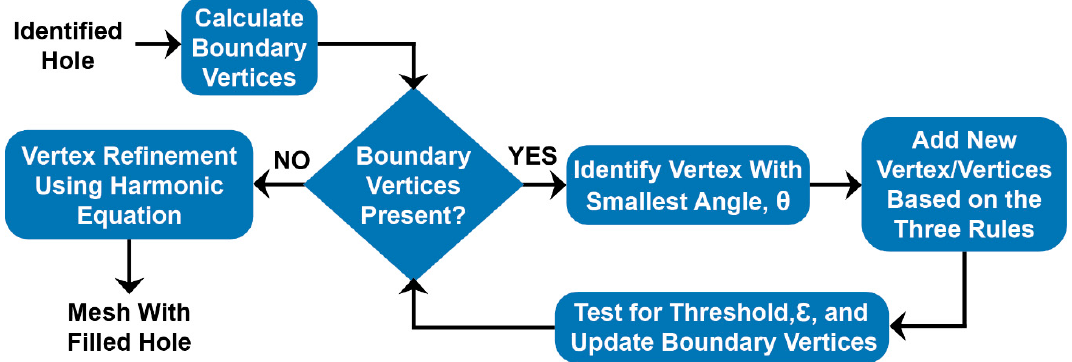
Figure 4 . Algorithm flowchart for hole filling. Each identified hole is run through this process to be filled. For each hole, the boundary vertices are found, and the advanced front mesh (AFM) technique is used to fill the hole. New vertex/vertices are added based on the rules detailed below.